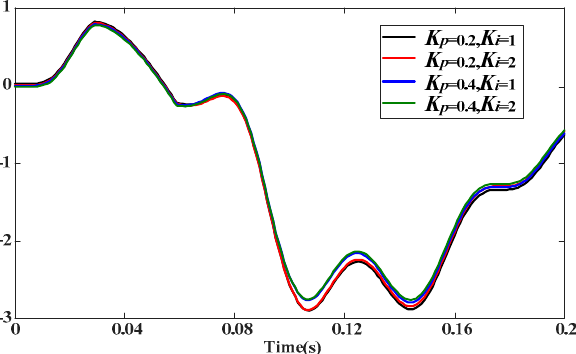
Figure 11. Reactive power characteristics of DFIG under different RSC parameters ( K p = K rdp = K rqp , K i = K rdi = K rqi ).